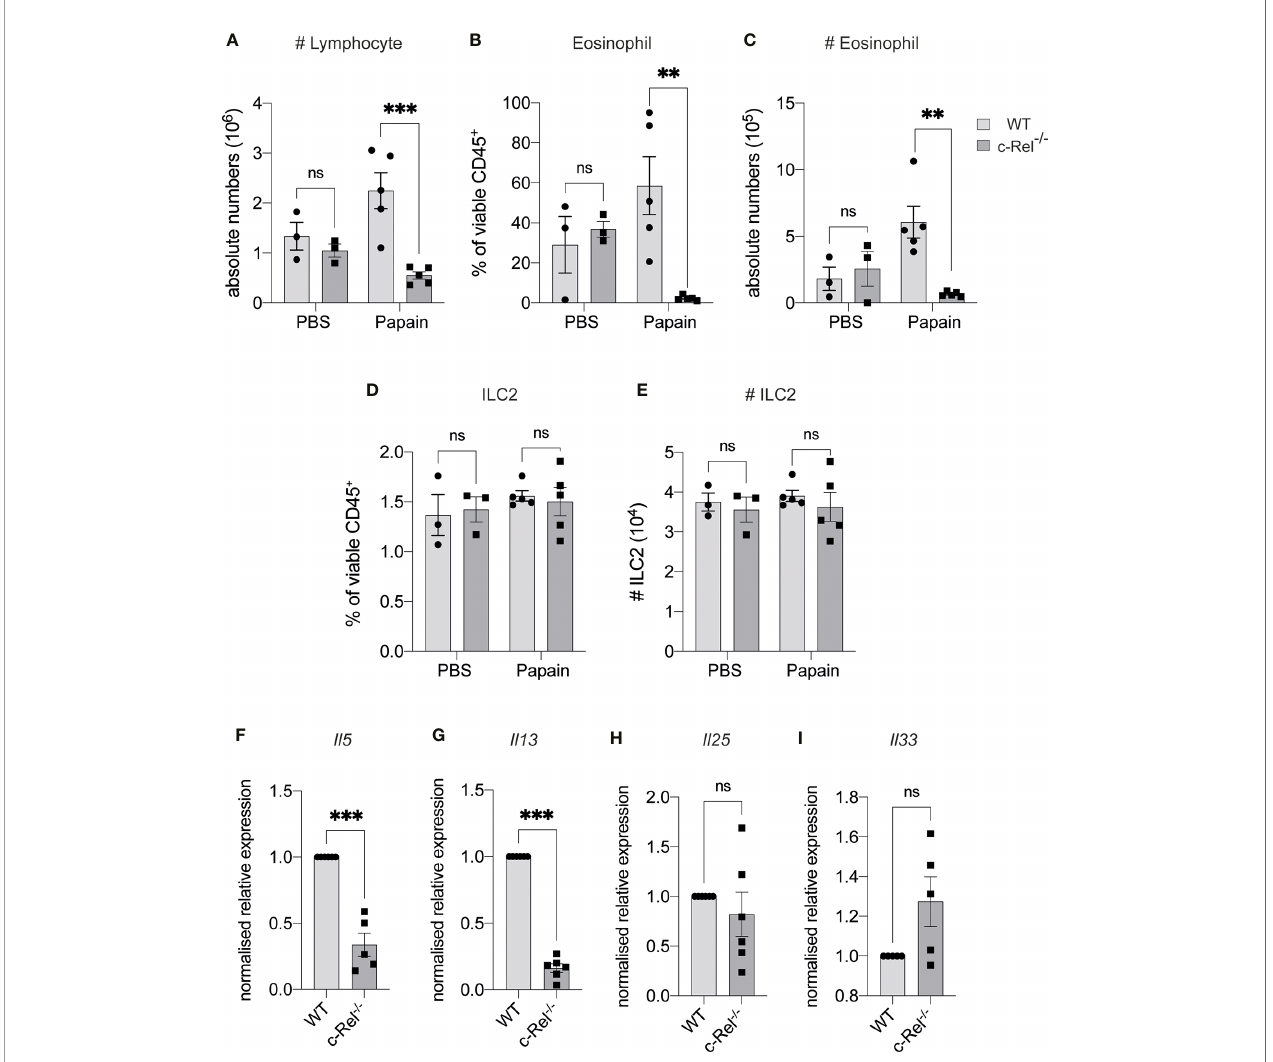
FIGURE 4 | c-Rel de fi ciency reduces papain-induced lung in fl ammation. (A) Absolute numbers of CD45 + lymphocytes in the bronchoalveolar lavage (BAL) fl uid following PBS (control) or papain challenge for three days. (B) Quanti fi cation of Siglec-F + CD11c - eosinophils in BAL among viable CD45 + cells. (C) Absolute numbers of BAL eosinophils. (D) Quanti fi cation of CD127 + KLRG-1 + lung ILC2s (gated on Lin - CD90 + CD25 + ST2 + ) among viable CD45 + cells. (E) Absolute numbers of lung ILC2s per animal. (F – I) qPCR analysis of the indicated genes from lung tissue following papain challenge. All graphs are representative of at least two independent experiments with 3-6 mice per group. Error bars represent ± SEM. **p ≤ 0.01, ***p ≤ 0.001. ns, non-signi fi